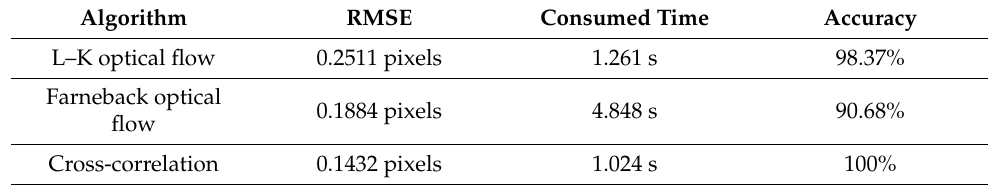
Figure 8. Displacement vector diagrams of the artificial speckle background. ( a ) L–K optical flow, ( b ) Farneback optical flow, and ( c ) cross-correlation. Table 4. Evaluation index of displacement extraction for the artificial speckle